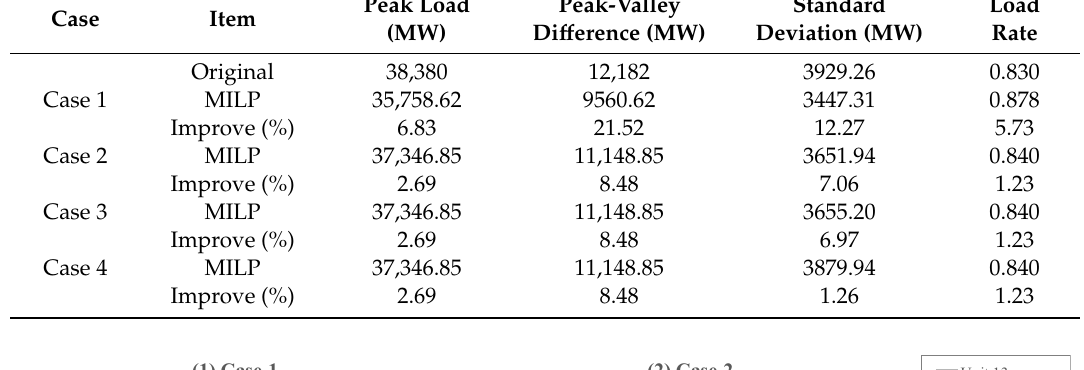
Table 5. Comparison of the original load and the optimized load obtained by MILP in Case 2.